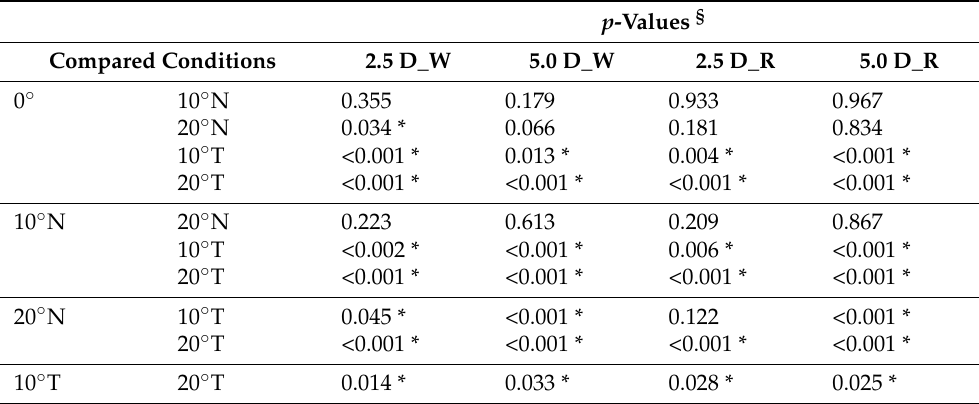
Table 2. Pair-wise differences in spherical equivalent according to eccentricity for each accommoda- tive demand and illumination (R: red; W: white).